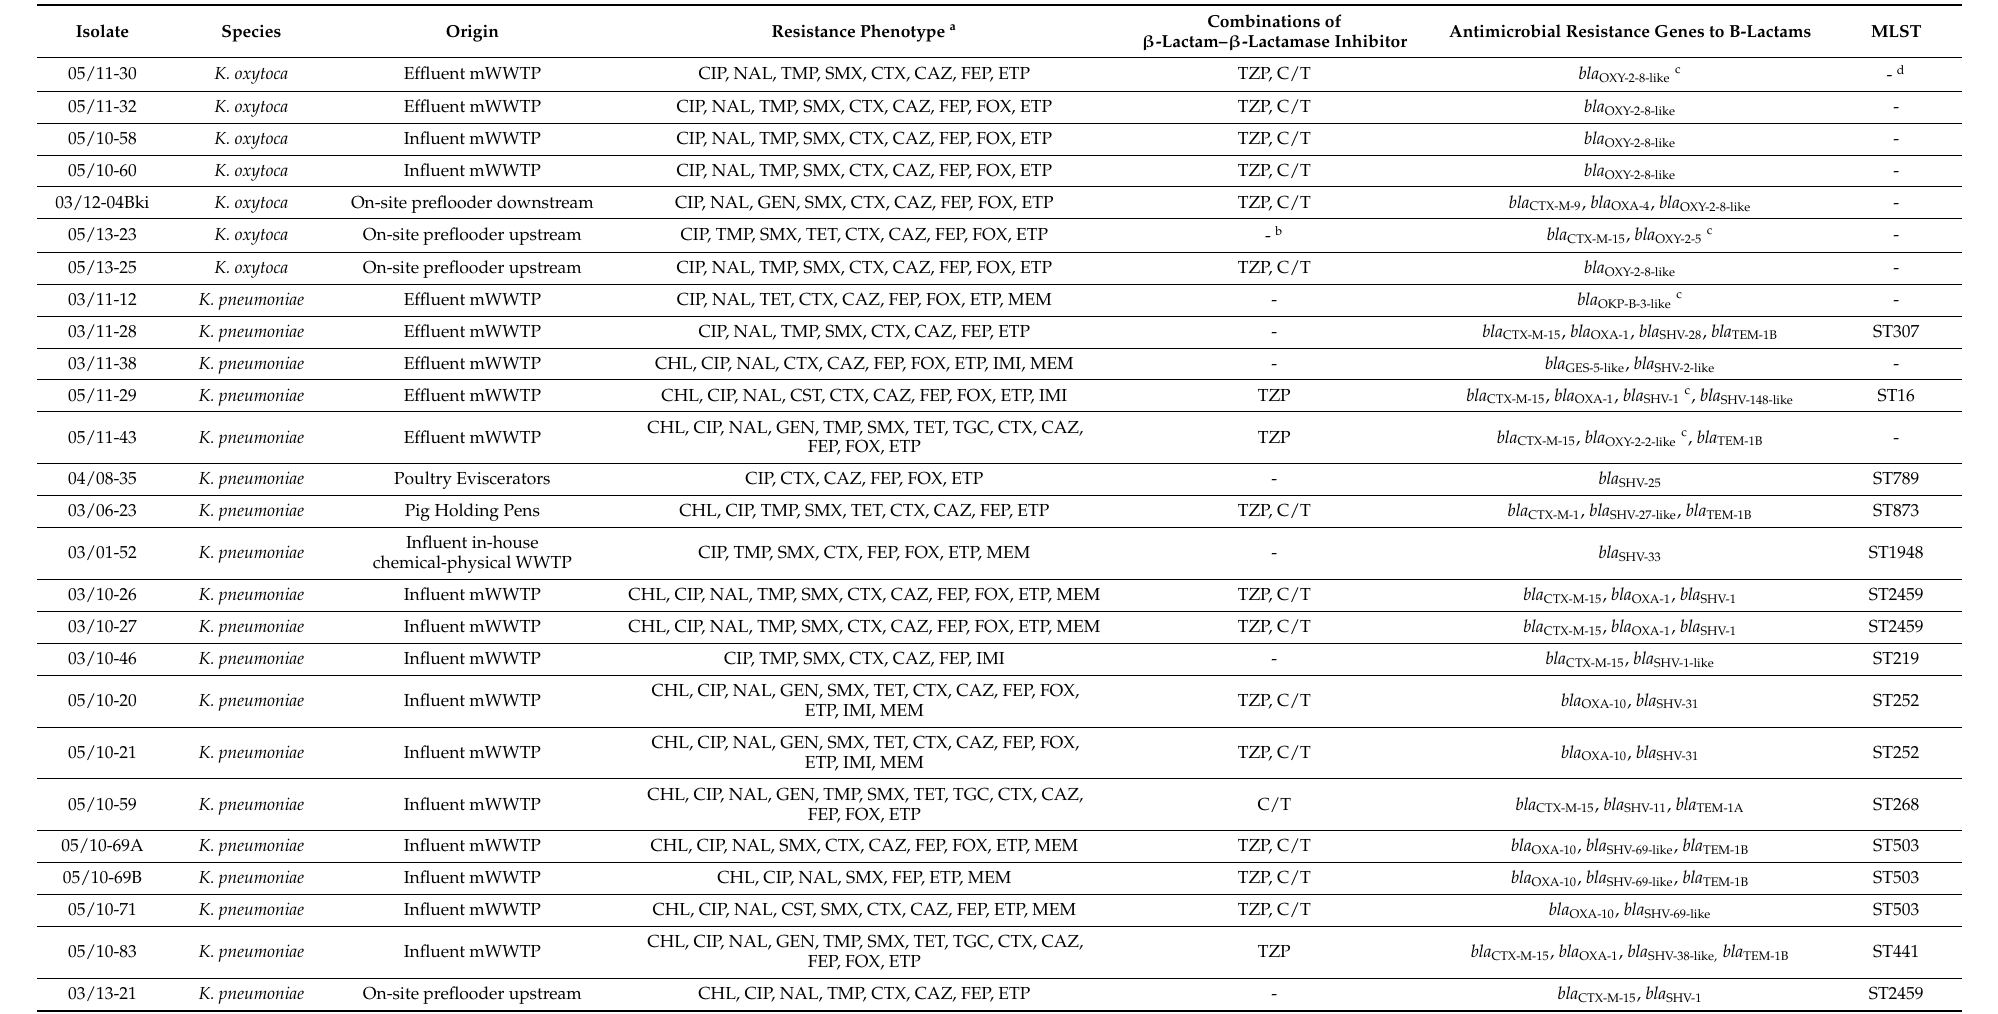
Table 1. Selected phenotypic and genotypic characteristics of carbapenem-resistant Klebsiella spp. isolates recovered from municipal WWTPs and their receiving water bodies as well as from process waters of poultry and pig